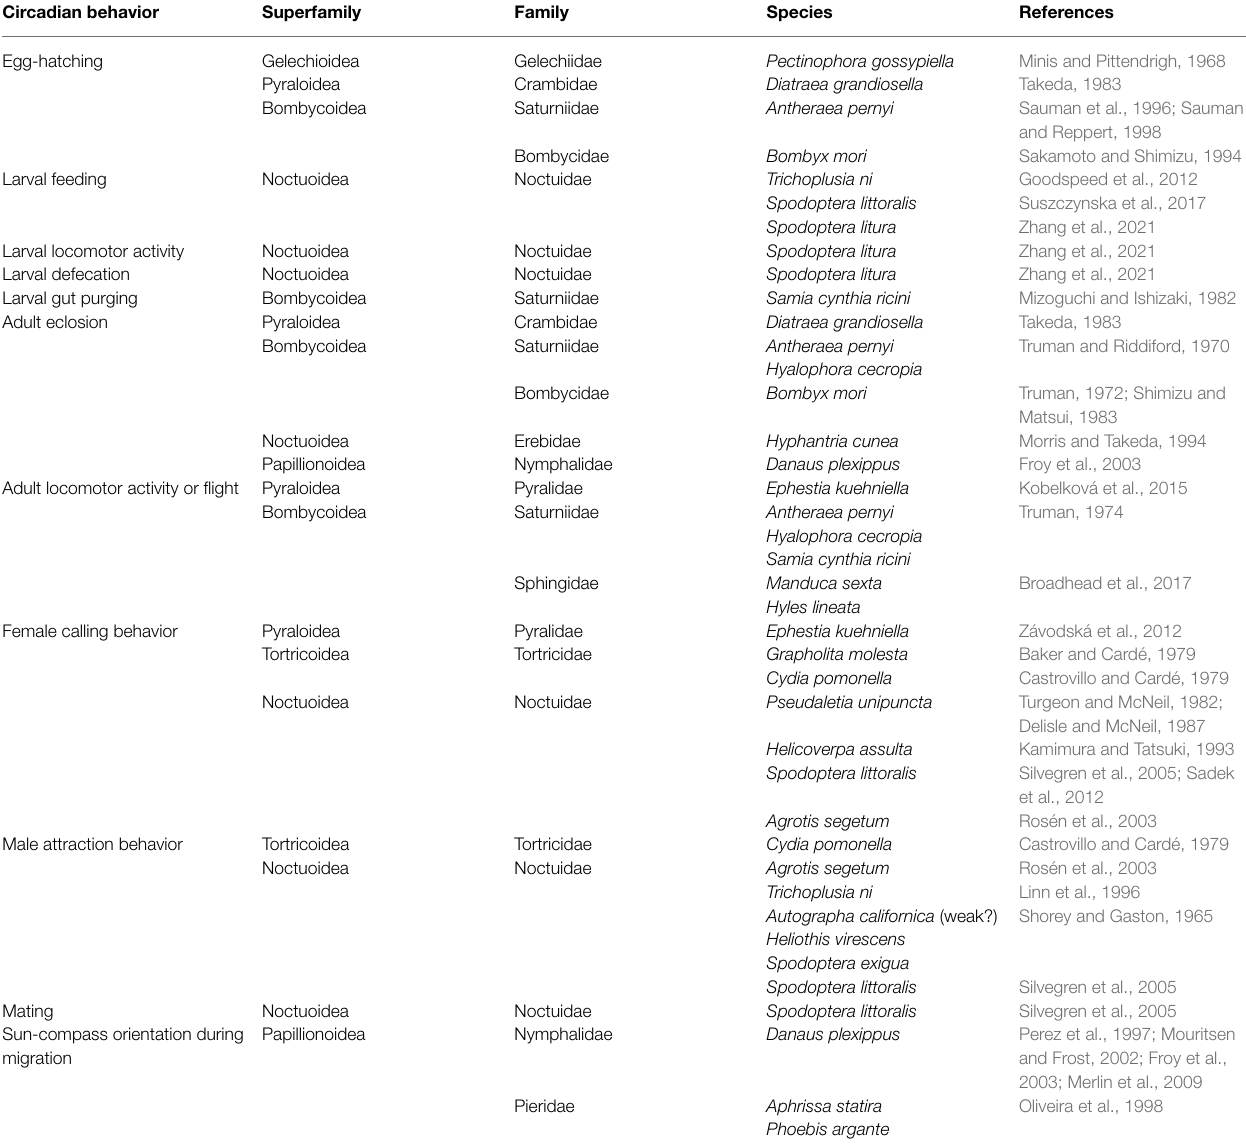
TABLE 1 | Circadian behavioral rhythms in Lepidoptera *